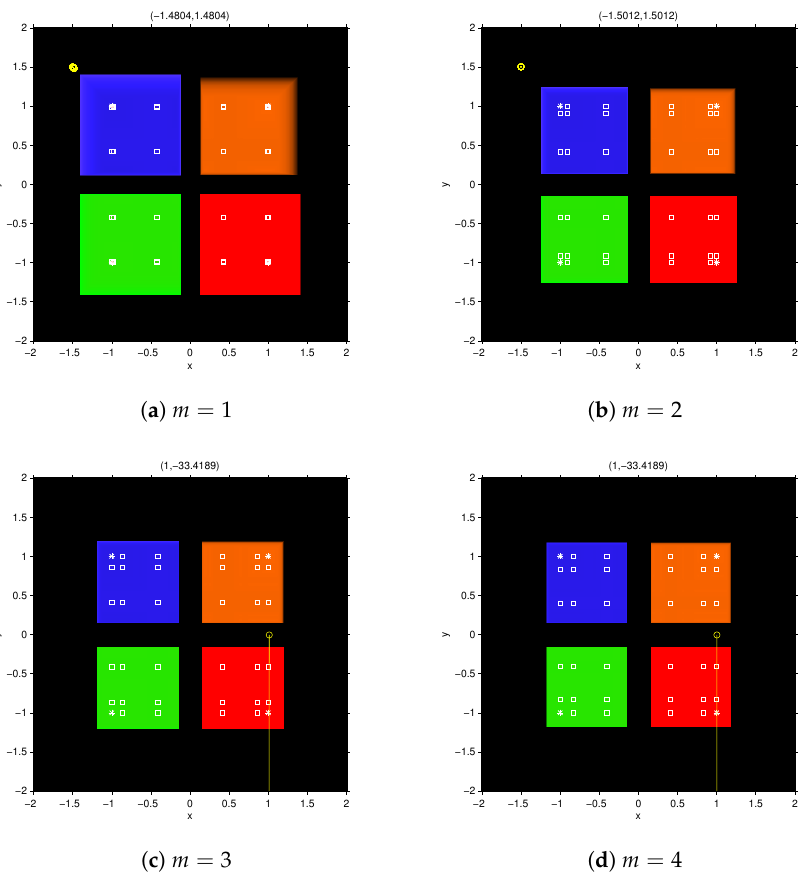
Figure 6. Dynamical plane for CMN m method, m = 1,2,3,4 on r ( x ) . Green, orange, red and blue areas are the basins of attraction of the roots of q ( x ) (marked as white stars); black area denotes divergence and white squares are free critical